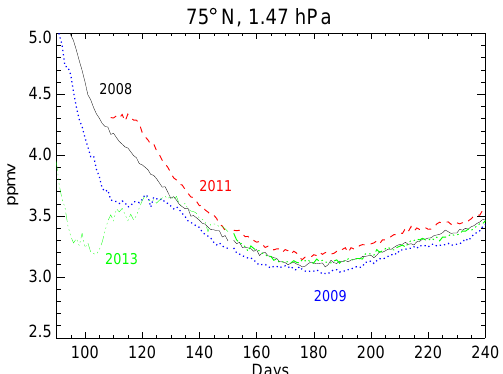
Figure 5. Time series of zonally averaged ozone from MLS at 75 ◦ N.